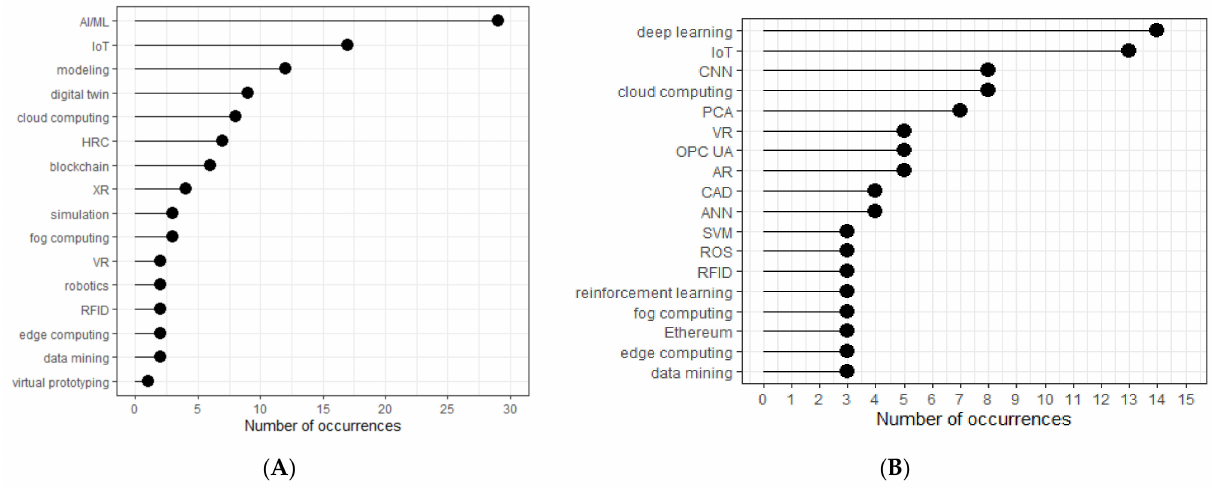
Figure 7. ( A ): Number of occurrences of technology categories. ( B ): Most frequently applied technologies in